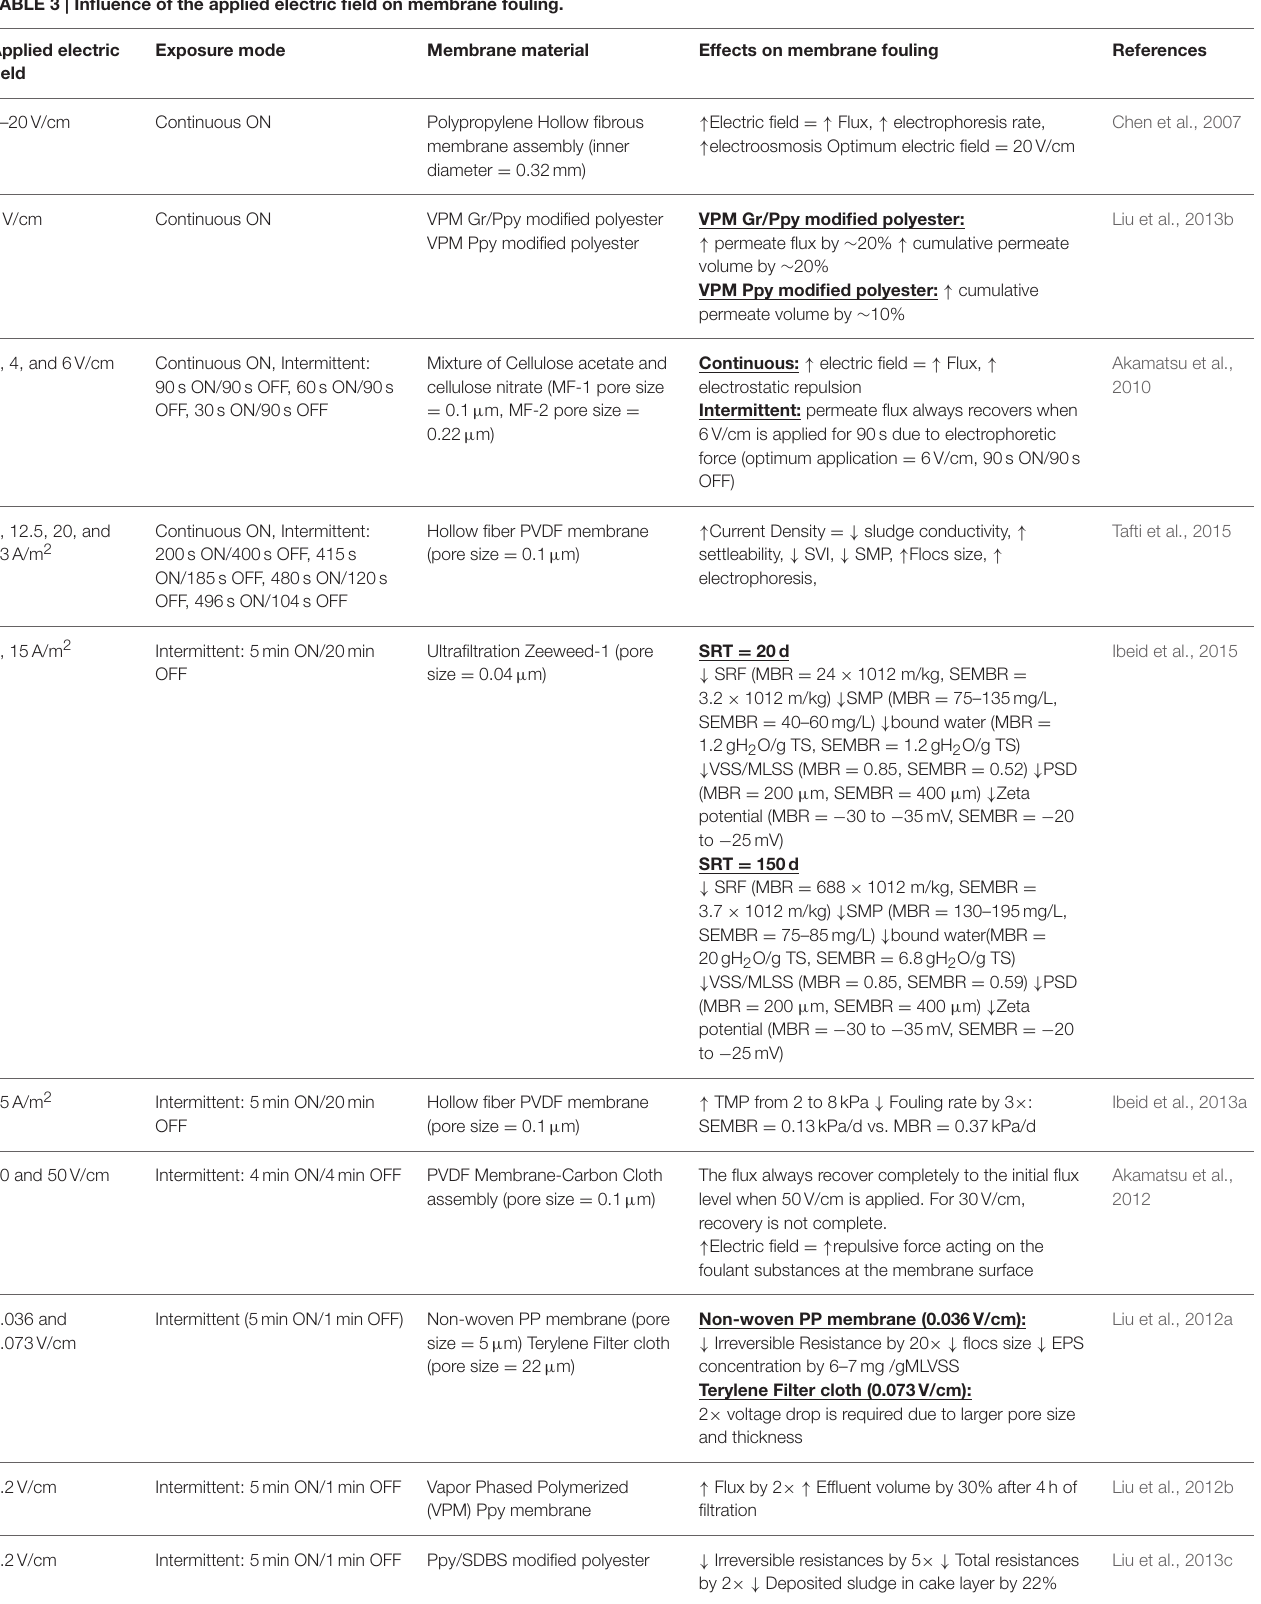
TABLE 3 | Influence of the applied electric field on membrane fouling. Applied electric